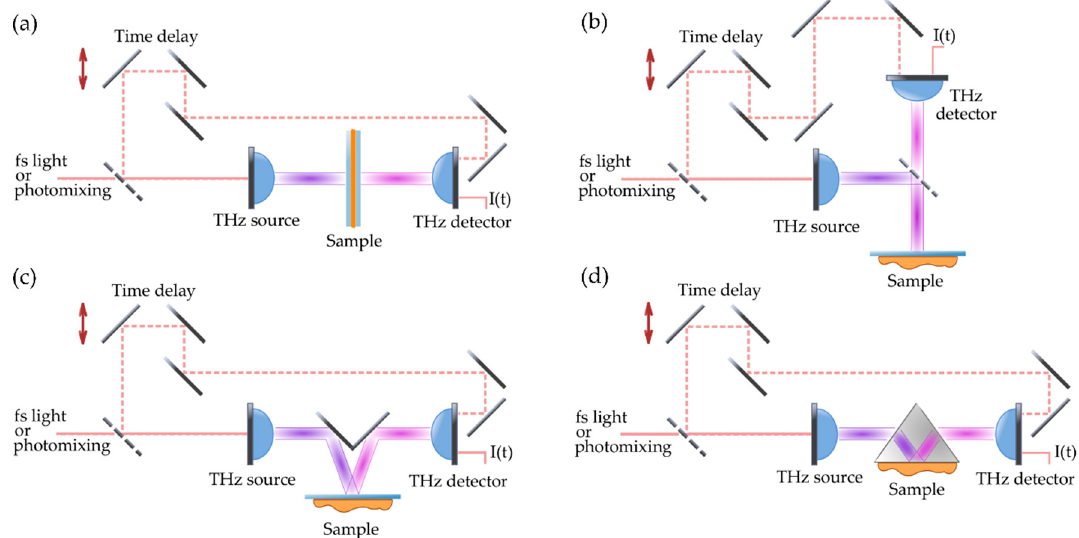
Figure 2. Schematic representation of typical terahertz (THz) measurement modes. Transmission mode ( a ), normal-incidence reflection ( b ), generalized reflection with an incidence angle ( c ), and attenuated total reflection (ATR) ( d ). The dashed line with the entire optical part is excluded for the continuous wave (CW) generation of THz waves, except for generation by photo mixing (courtesy of M. Konnikova).